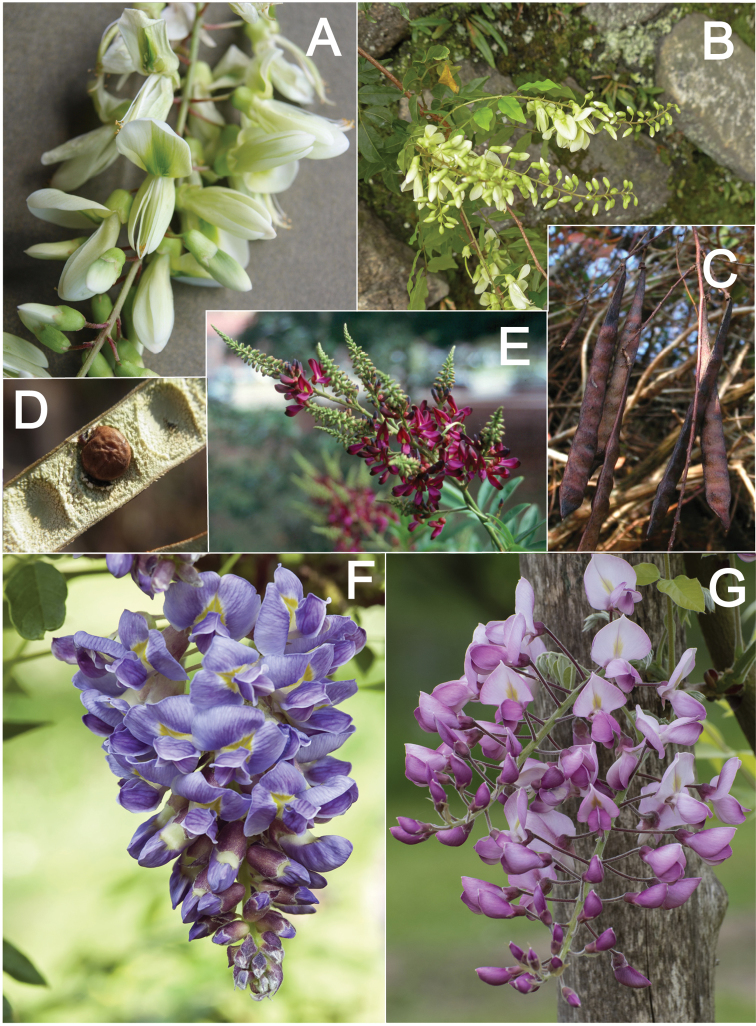
Wisteriopsis and Wisteria. AWisteriopsisjaponica, Cultivated, J.C.Raulston Arboretum, North Carolina 980008-17 BWisteriopsisjaponica Japan, Honshu near Kyoto G.Lewis, unvouchered C, DWisteriopsisjaponica, Cultivated, J.C.Raulston Arboretum, North Carolina 980008-17 EWisteriopsisreticulata Cultivated, J.Compton s.n.. unvouchered FWisteriafrutescens Cultivated, B.Schrire unvouchered GWisteriabrachybotrys cultivated, B.Schrire unvouchered.